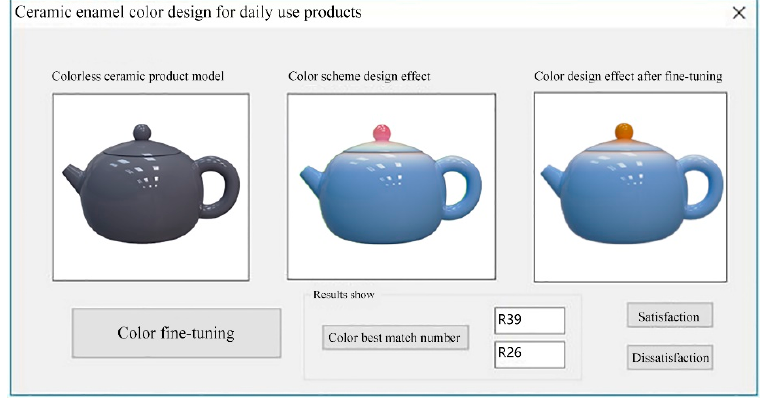
Figure 10. Effect of re-coloration of ceramic daily products after fine adjustment.